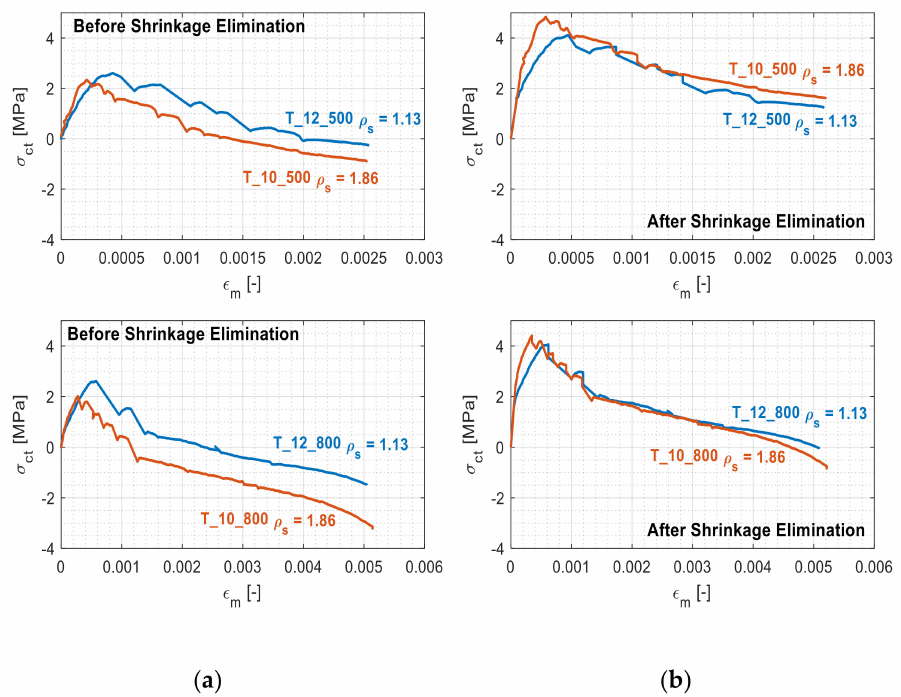
Figure 7. Comparison of the tension stiffening behaviors of the study case members with different reinforcement ratios before ( a ) and after ( b ) the shrinkage